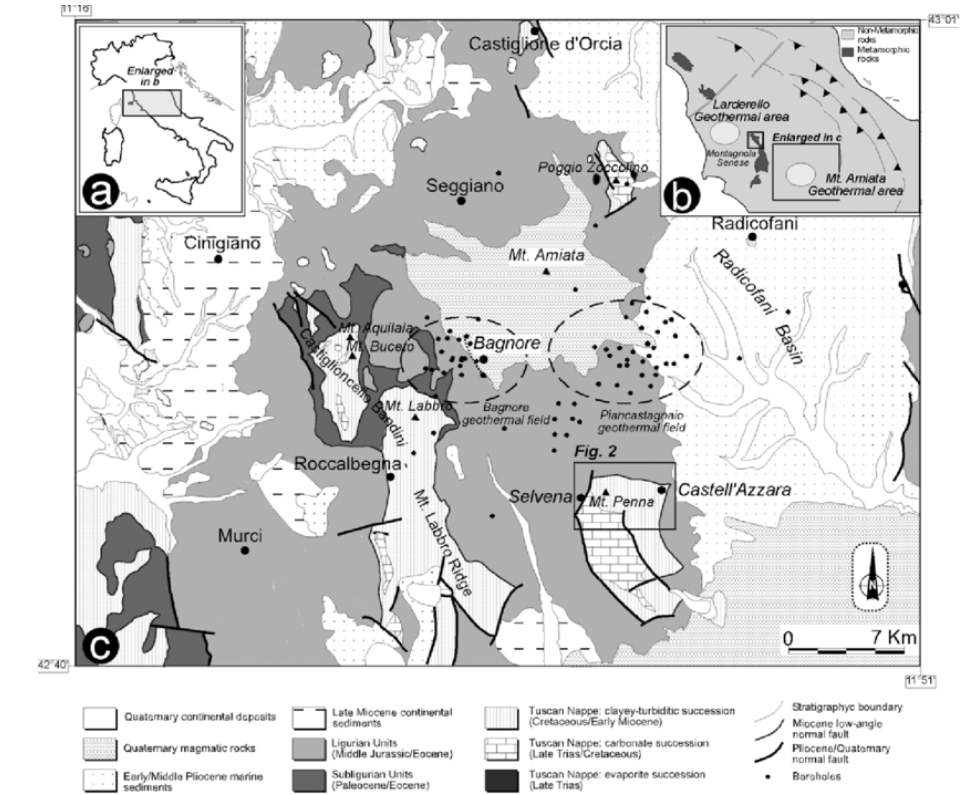
Figure 6. The monastery at La Verna sits on Mt. Penna (see also Fig. 17), a Miocene calcarenite. It is highly fractured, and many caverns and clefts are etched into its surface. Boulders and scree surround the base of the mountain. It rests on Cretaceous successions belonging to the eastern Ligurian units (Sillano Formation; Early Cretaceous). After Brogi and Fabbrini